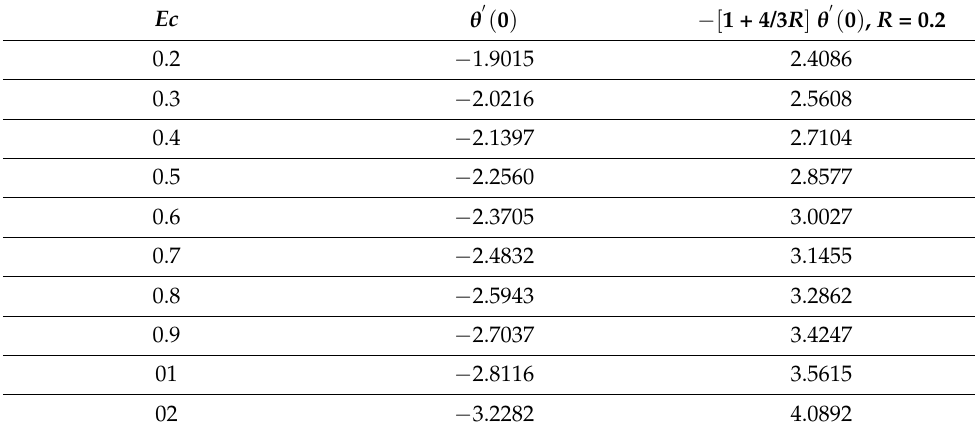
Table 5. Impact of Eckert number on Nusselt number.